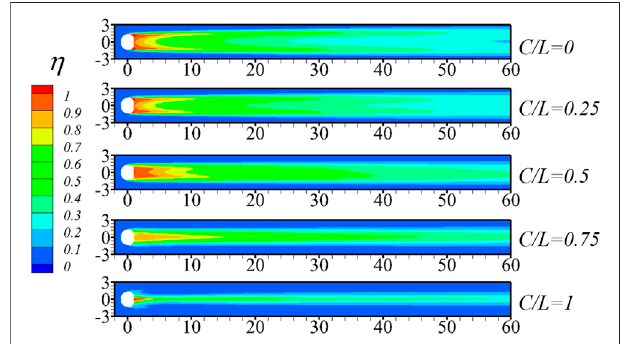
FIGURE 10 | Spanwise average ef fi ciency in M (cid:2) 1.5 condition.